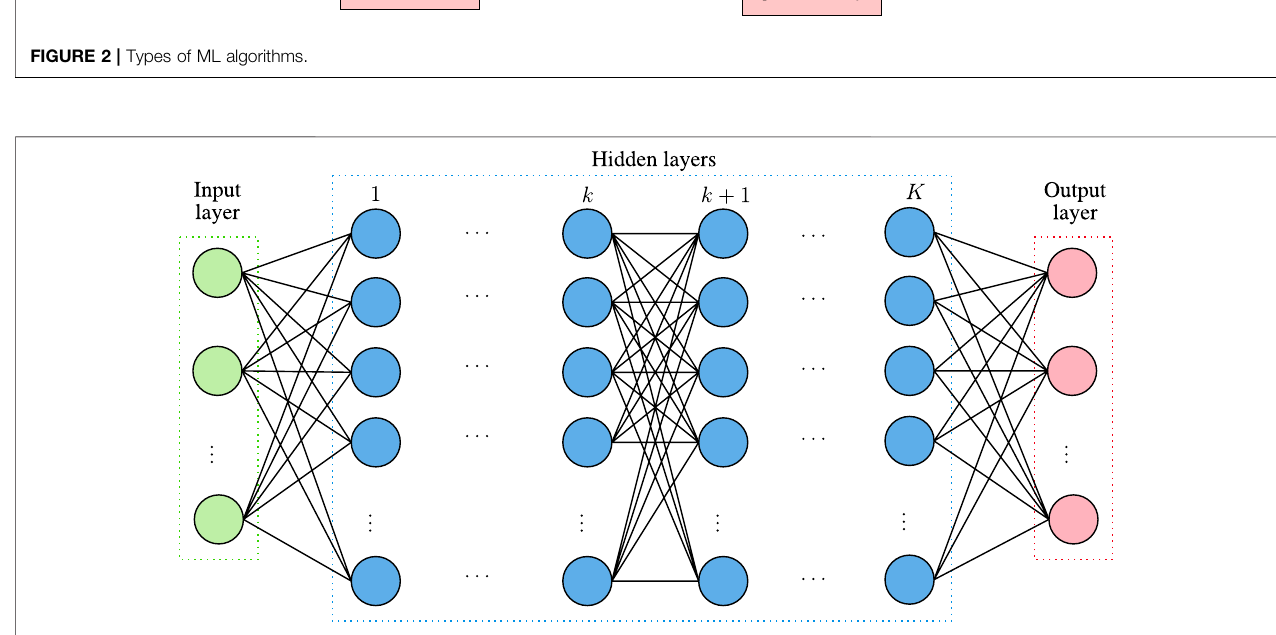
FIGURE 2 | Types of ML algorithms.